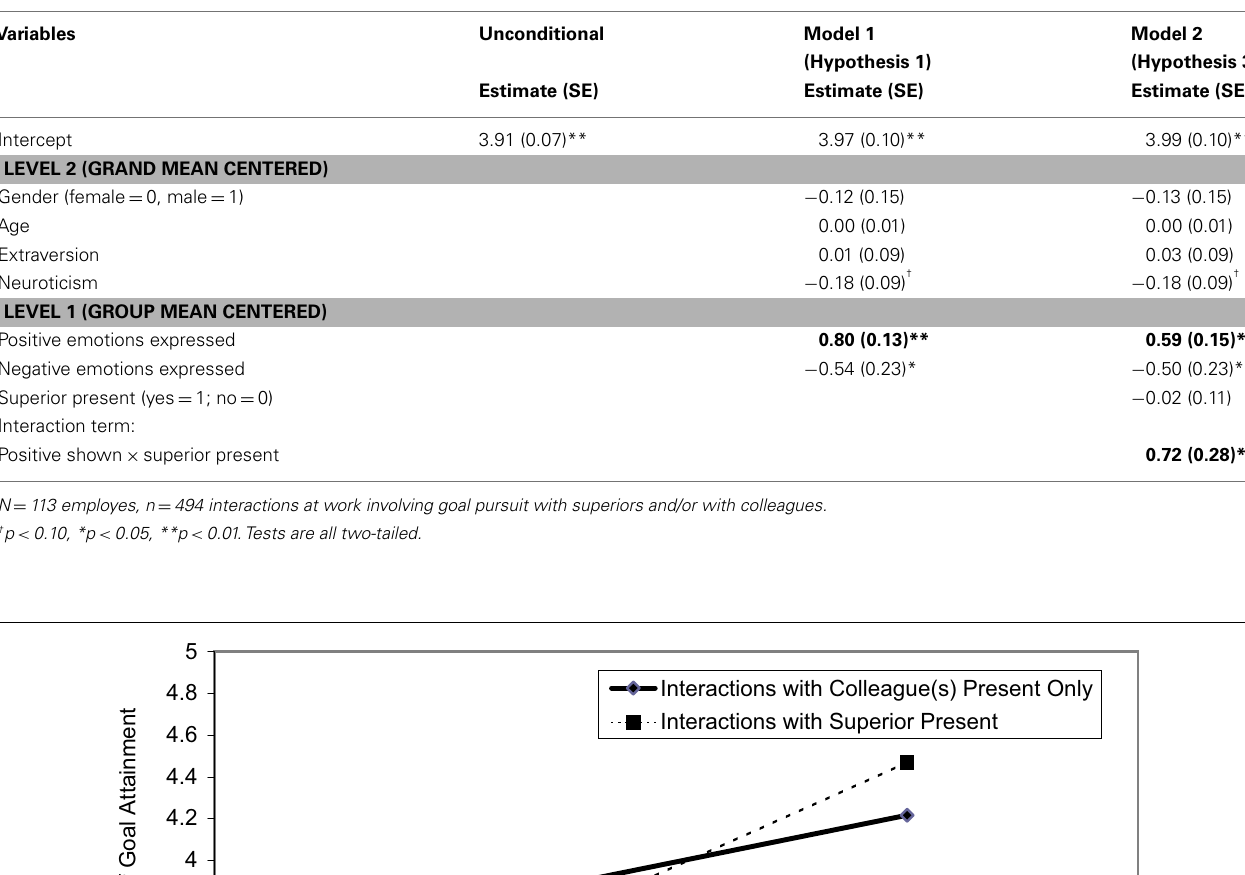
Table 3 | Predicting goal attainment in workplace interactions by expressing positive emotions (Hypothesis 1 and Hypothesis 3).